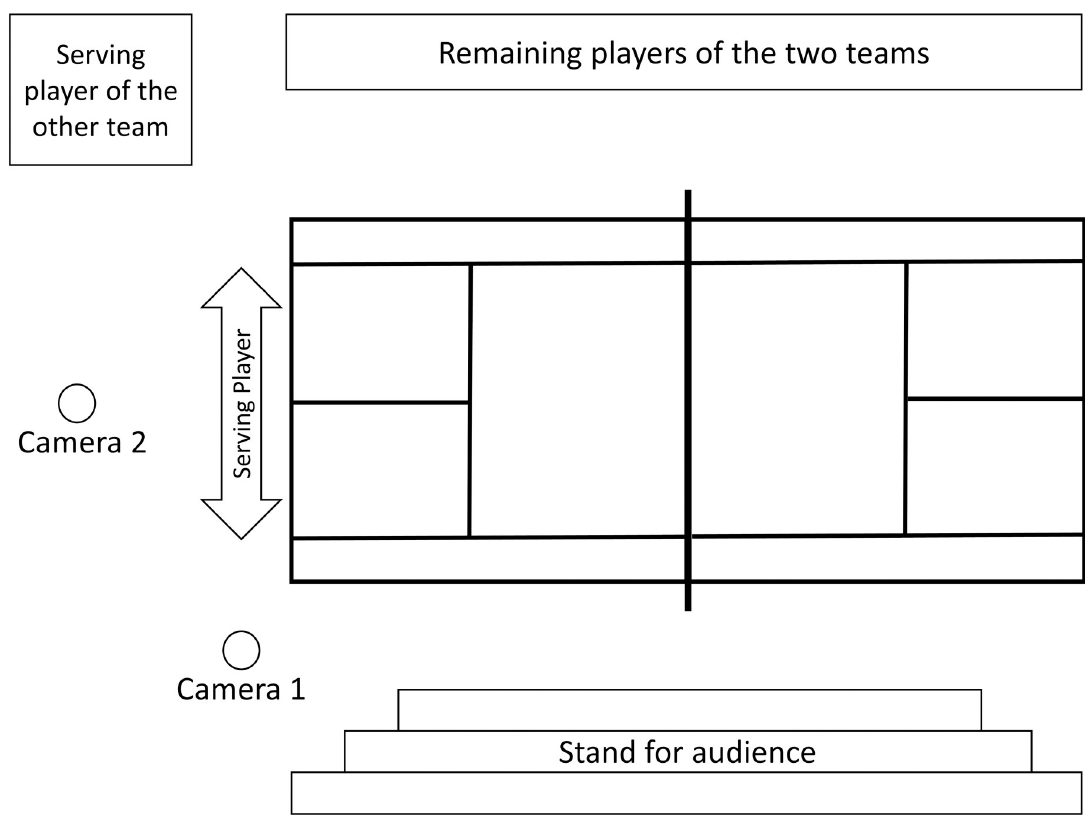
Fig 2. Experimental setup for the post-test phase performed under